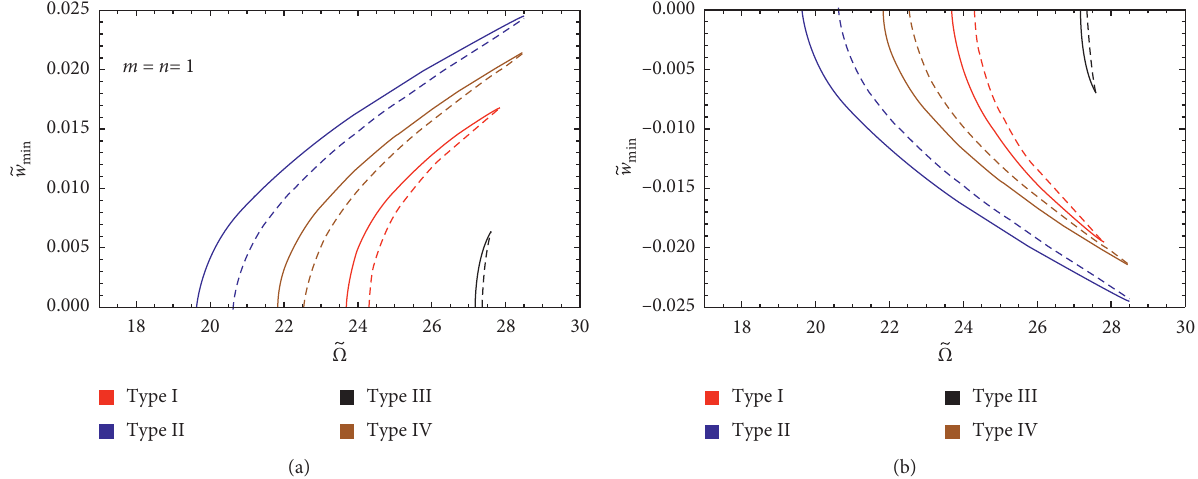
Figure 4: Frequency-response curves of the transverse motions 􏽥 w of four type of BDFG beam with m � n � 1, L / h � 20, 􏽥 c � 5, and P � 1 . 5. (a, b) Maximum and minimum amplitudes of transverse motion 􏽥 w P s d